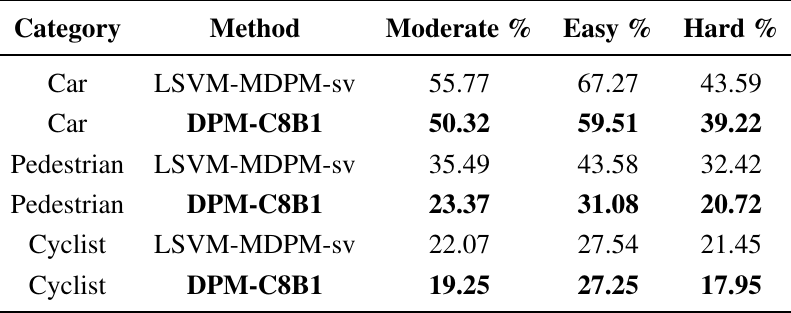
Table 2. Joint object detection and orientation